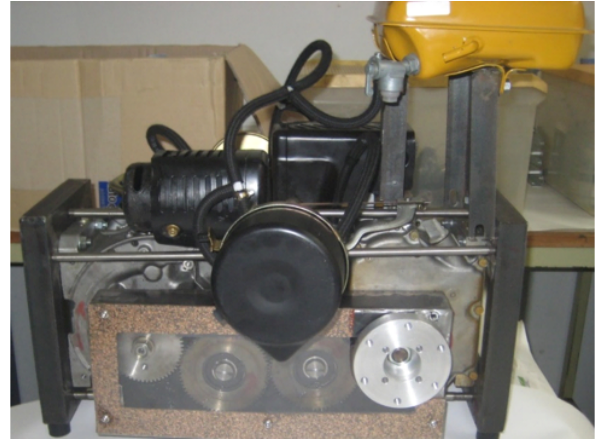
Figure 4: Final positioning of the reciprocating piston engine PTO for this design.